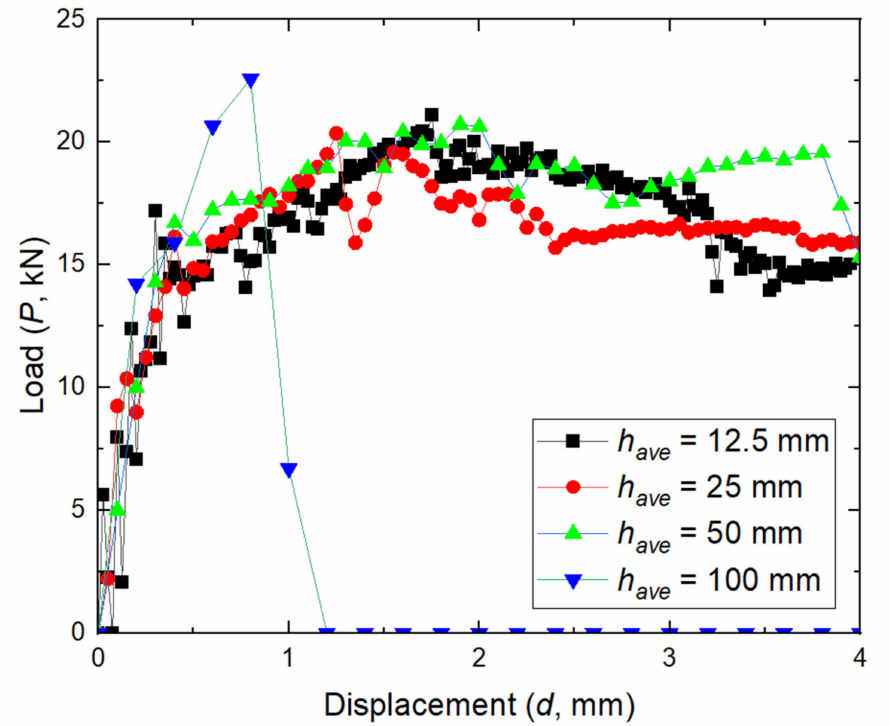
Figure 10. Applied loading ( P )–displacement ( d ) curves in the three-point bending test for the RC beam with different element size h ave